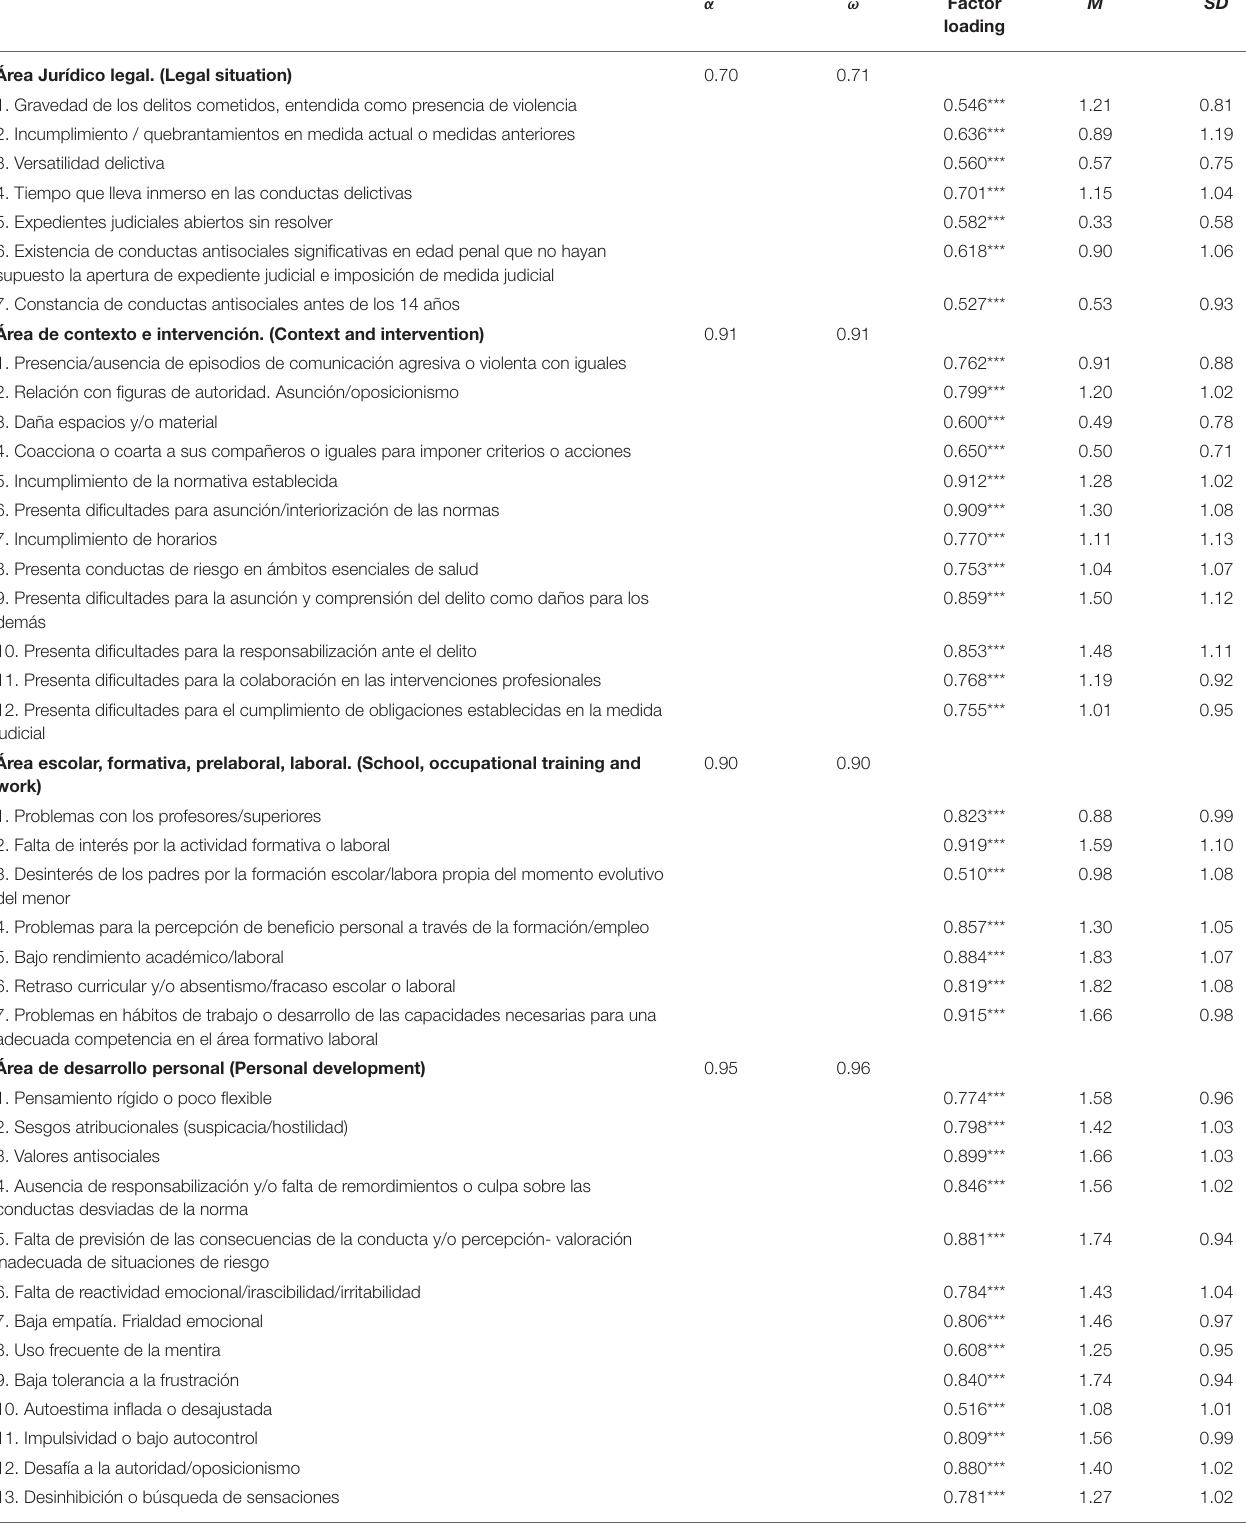
M SD α ω Factor loading